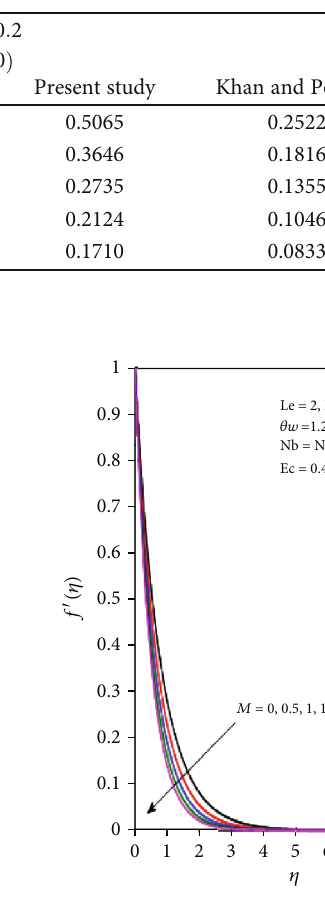
Table 1: A comparison between the numerical results of Khan and Pop [8] and the results of the current study through the values of − θ ′ ð 0 Þ in the case of Pr = Le = 10 and in the absence of both M , Da, Ec, γ , S , and λ .